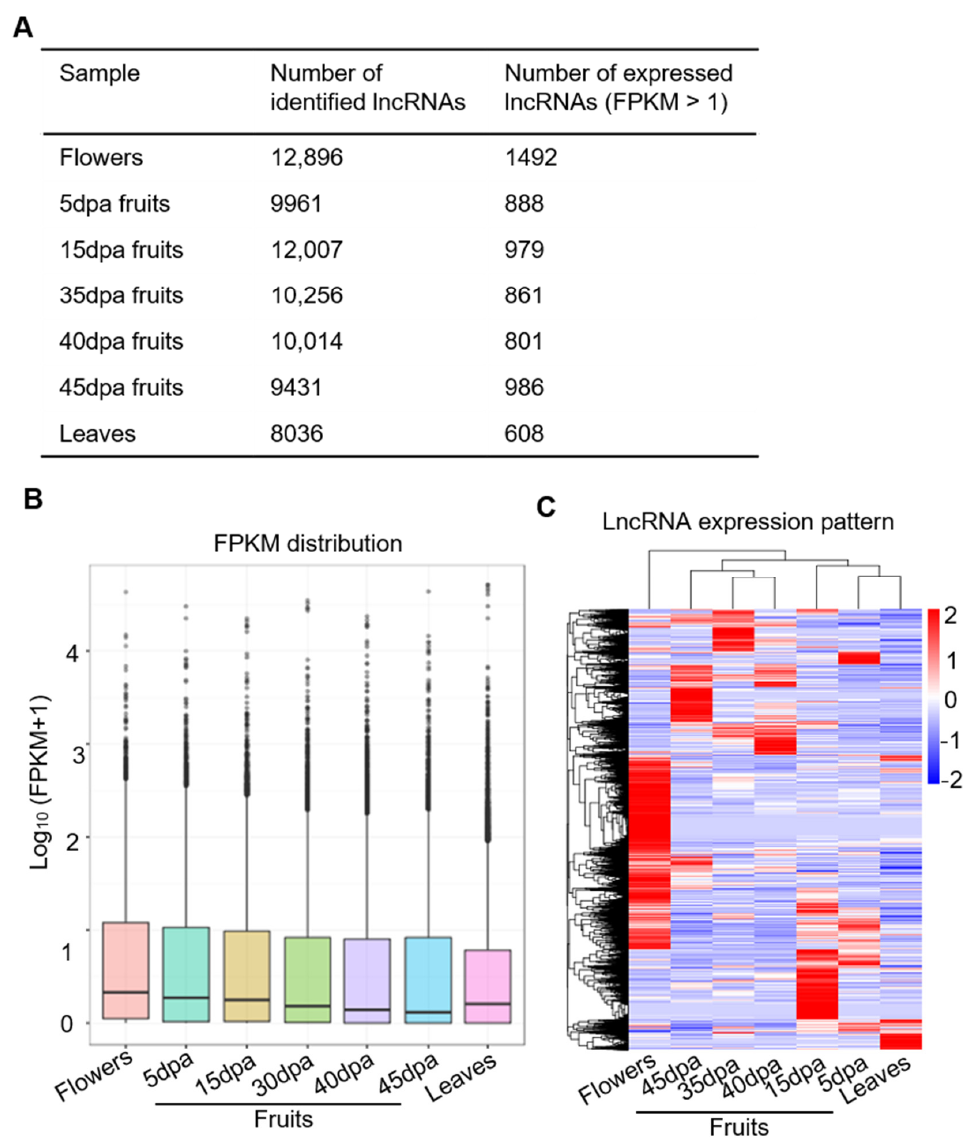
Figure 2. Tissue specific expression pattern and expression level of lncRNAs in tomato fruits at different stages. ( A ) The number of lncRNAs identified in different tissues and in different stages of tomato fruits. ( B ) The boxplot representation showing the expression level of transcripts in the indicated samples. ( C )The heatmap representation of all of the identified lncRNAs in this study. The expression patterns were varied among flowers, fruits, and leaves.